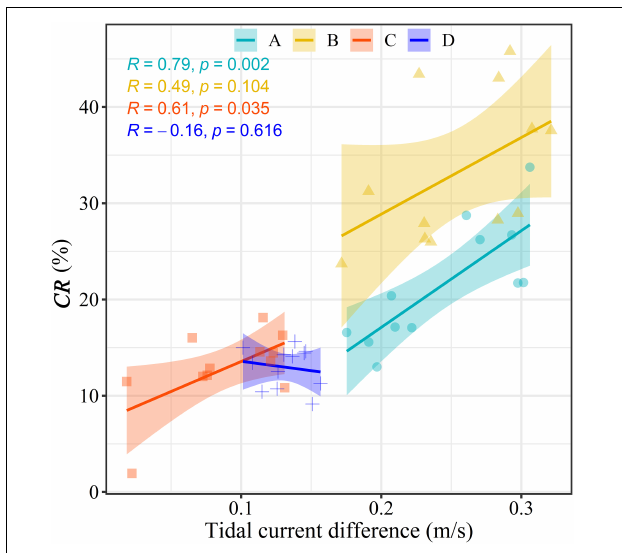
FIGURE 10 | Scatter plots of the spring-neap tidal current difference maximum and Chl- a contribution rate ( CR ) in areas A, B, C, and D.